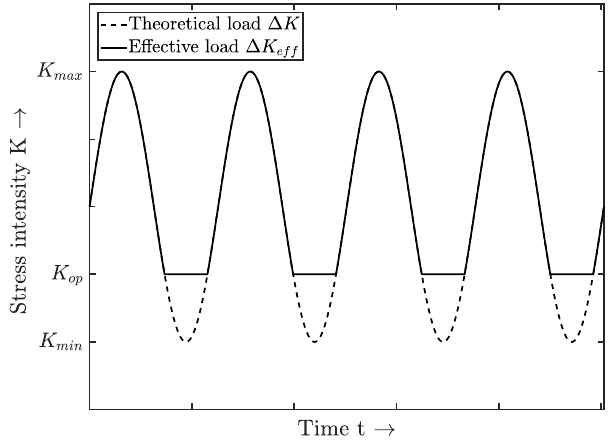
Figure 1. Effective load stress intensity factor due to crack closure